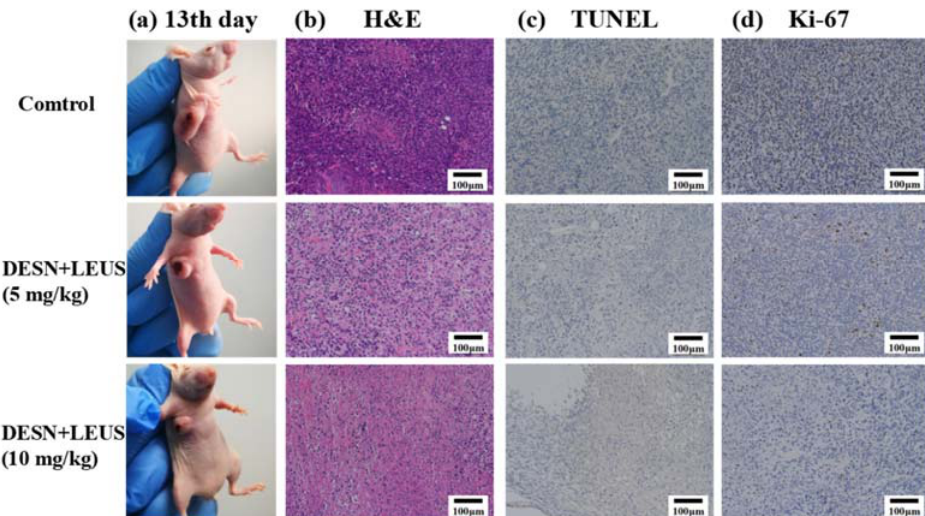
Figure 9. ( a ) Photographs of 4T1-tumor-bearing mice and their tumor regions 13 days after the treatment; ( b ) H&E staining for pathological changes in tumor tissues from each group to reveal the effectiveness of in vivo chemo-sonodynamic therapy by intravenous/intratumoral administration of DESN; ( c ) TUNEL staining for pathological changes in tumor tissues and ( d ) Antigen Ki-67 immunofluorescence staining for cellular proliferation in tumor sections.